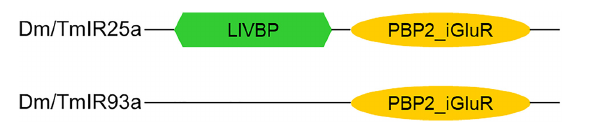
FIGURE 3 | Protein domains in Dm/TmIR25a and Dm/TmIR93a. Tm/DmIR25a contains a leucine/isoleucine/valine-binding protein (LIVBP)-like domain at the N-terminus and PBP2_iGluR domain (ligand-binding and ion channel domains) similar to iGluRs. Tm/DmIR93a contains only the PBP2_iGluR domain similar to other